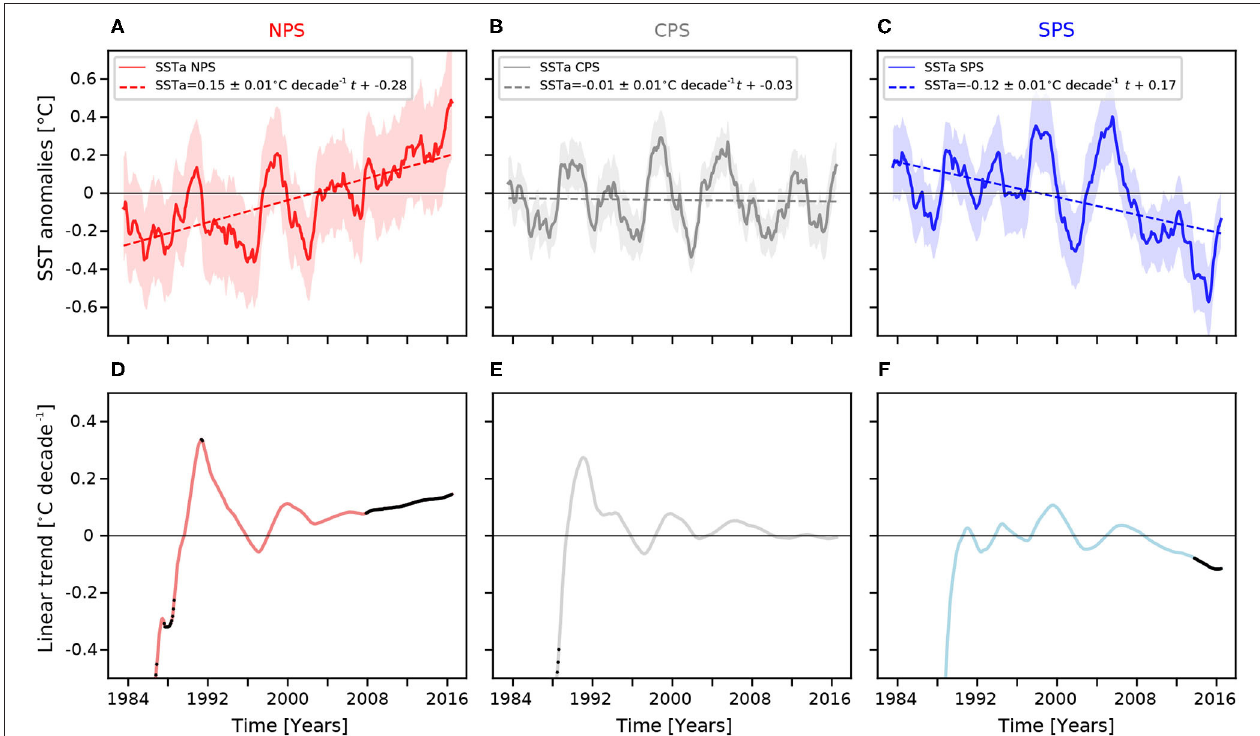
FIGURE 5 | (Top) Time series of 36-month running mean of SSTa (solid line), standard deviation (shaded) and linear trend fit (dashed line), together with their corresponding linear trends based on the SST data set described in Section 2.1 at (A) NPS (B) , CPS, and (C) SPS shown in Figure 1B . The construction of the SSTa time series for each regions is described in Section 2.3. Trends at NPS and SPS are significant at the 95% confidence level. (Bottom) Temporal evolution of linear trend slope between 1982 and 2017, at (D) NPS, (E) CPS, and (F) SPS. Values for the time steps when the linear trends are significant at 95% confidence level are marked in